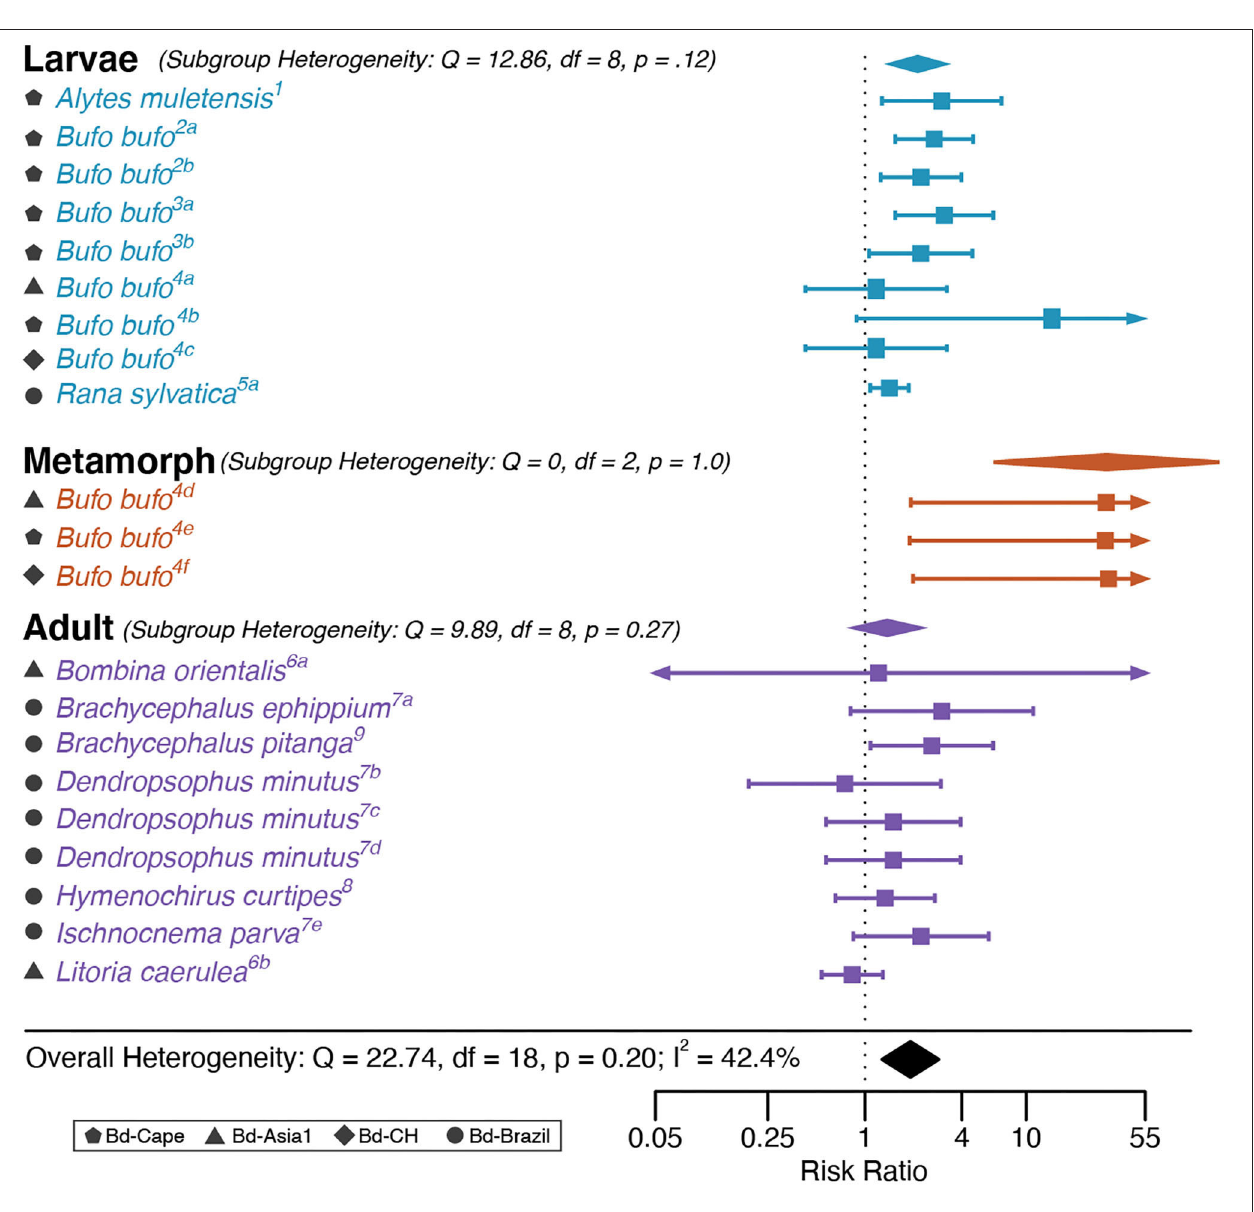
FIGURE 2 | Historical Adaptation analysis forest plot depicting Risk Ratio effect sizes for each life stage category. Squares indicate mean effect size for each study unit and error bars depict 95% Confidence Interval (CI). The meta-analytic mean effect size across study units (black diamond) was calculated without any subgroup moderator terms. Arrows on error bars indicate that the CI exceeds the provided x-axis scale. Study unit ID numbers correspond to Table 1 . Heterogeneity test statistics (Q), degrees of freedom (df), and p -values for Cochran’s Q test of heterogeneity are reported for each subgroup and the overall model.